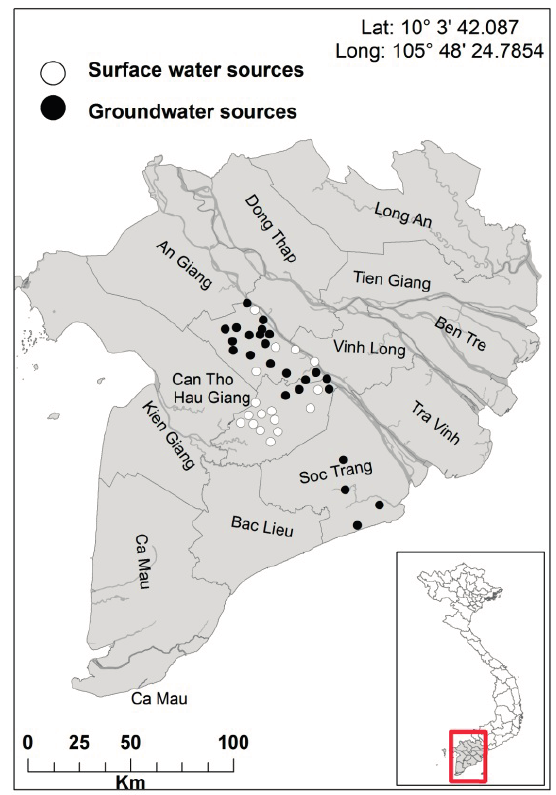
Figure 1. Overview of the MD and the selected water supply stations for water quality analysis. The white dots indicate water supply stations that use surface water sources while the black dots represent supply stations that use groundwater